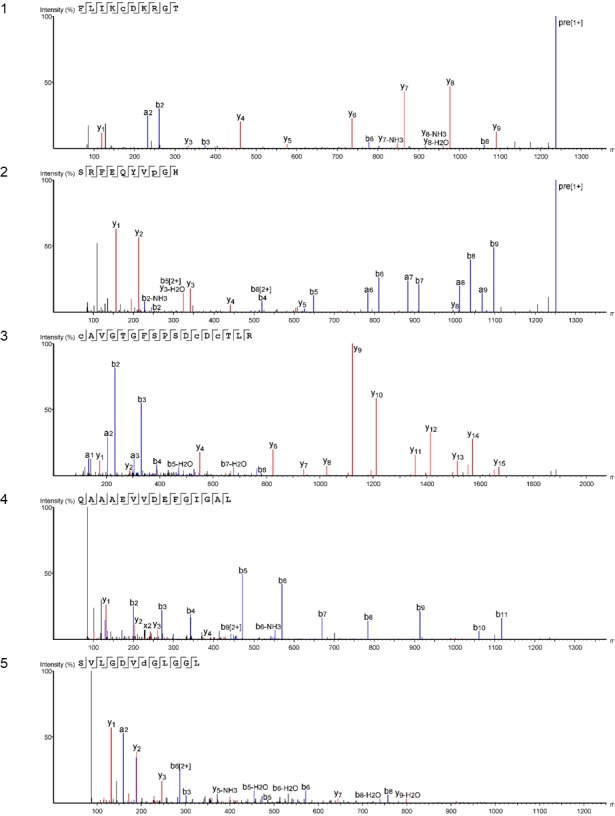
Product ion spectra [1 - 5] supporting the coverage of protein Hic74 identified in Unio pictorum.